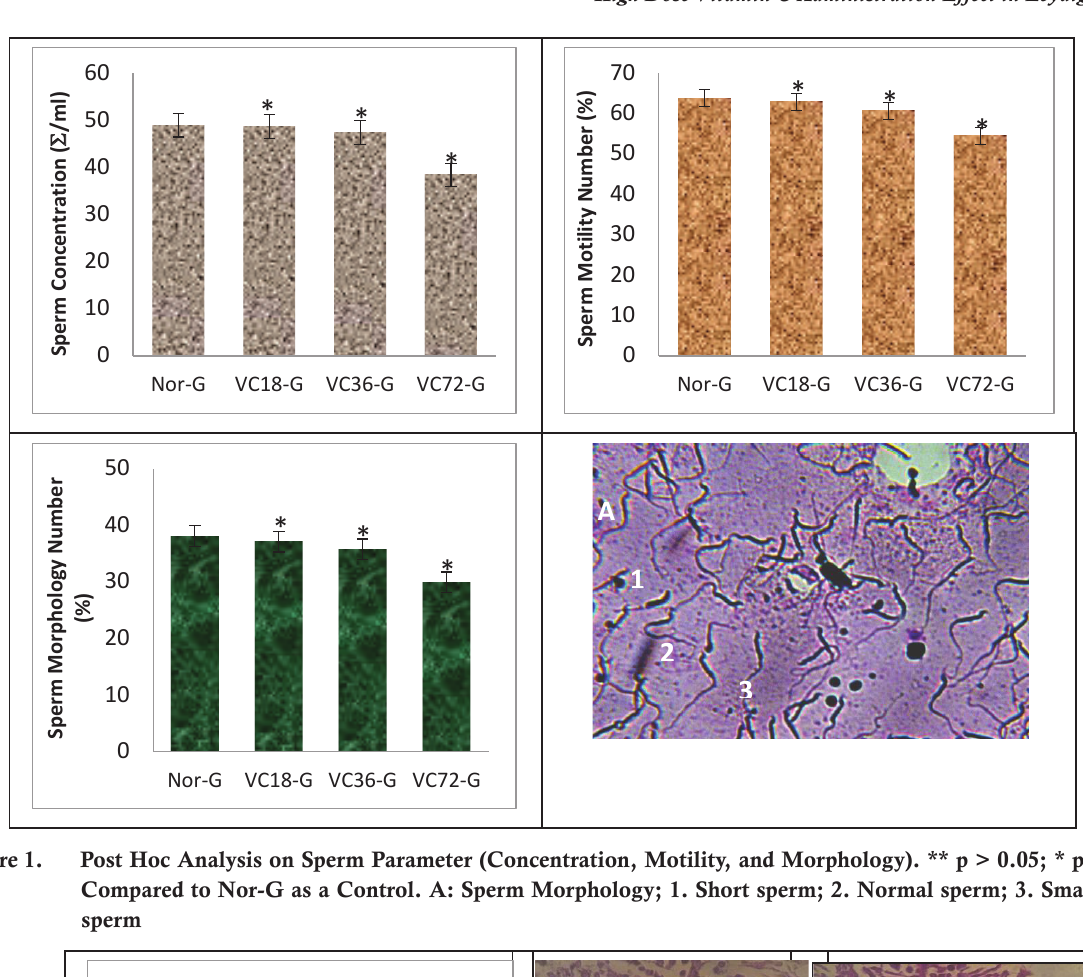
Figure 1. Post Hoc Analysis on Sperm Parameter (Concentration, Motility, and Morphology). ** p > 0.05; * p < 0.05 Compared to Nor-G as a Control. A: Sperm Morphology; 1. Short sperm; 2. Normal sperm; 3. Small Head